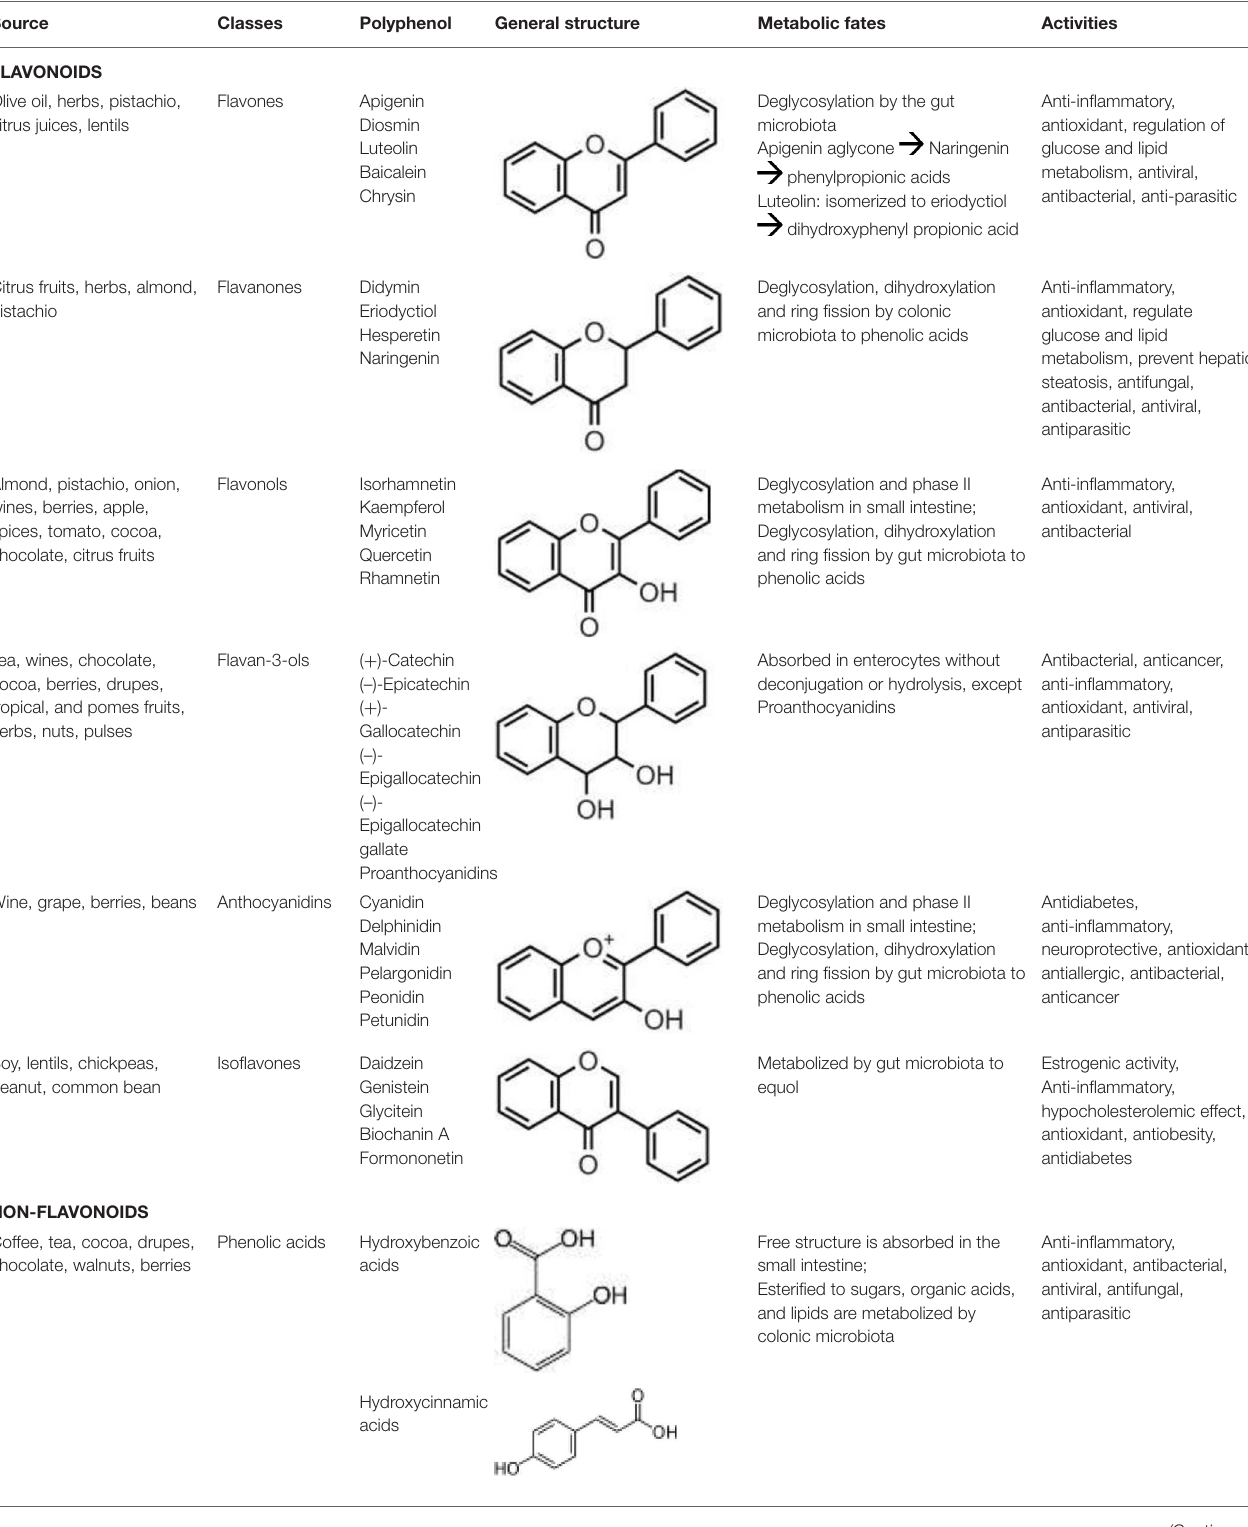
TABLE 1 | Polyphenols characterization, metabolism, and biological activities (13,